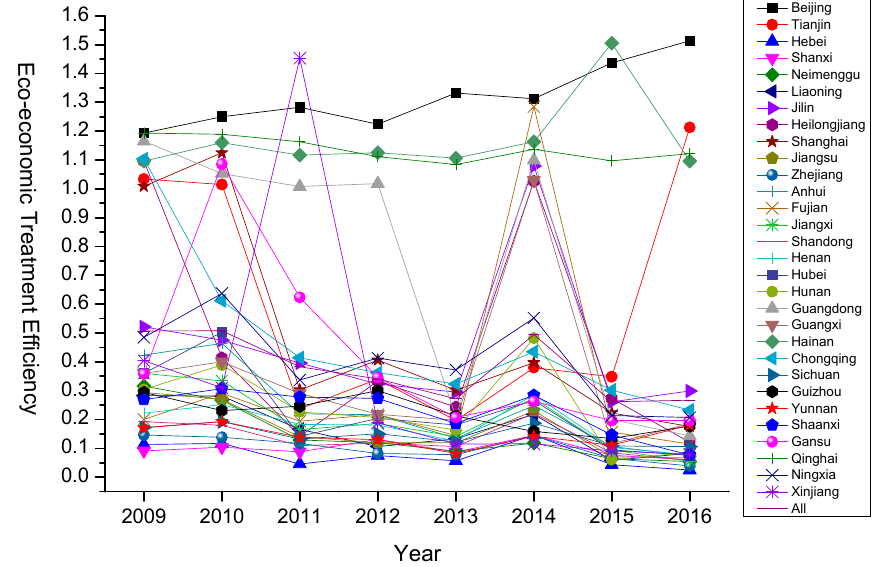
Figure 2. Time trends of eco-economic treatment efficiency in different regions in China (2009–2016).